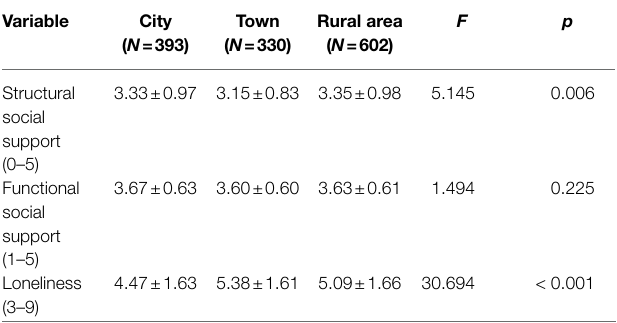
TABLE 2 | Structural social support, functional social support, and loneliness of older adults by